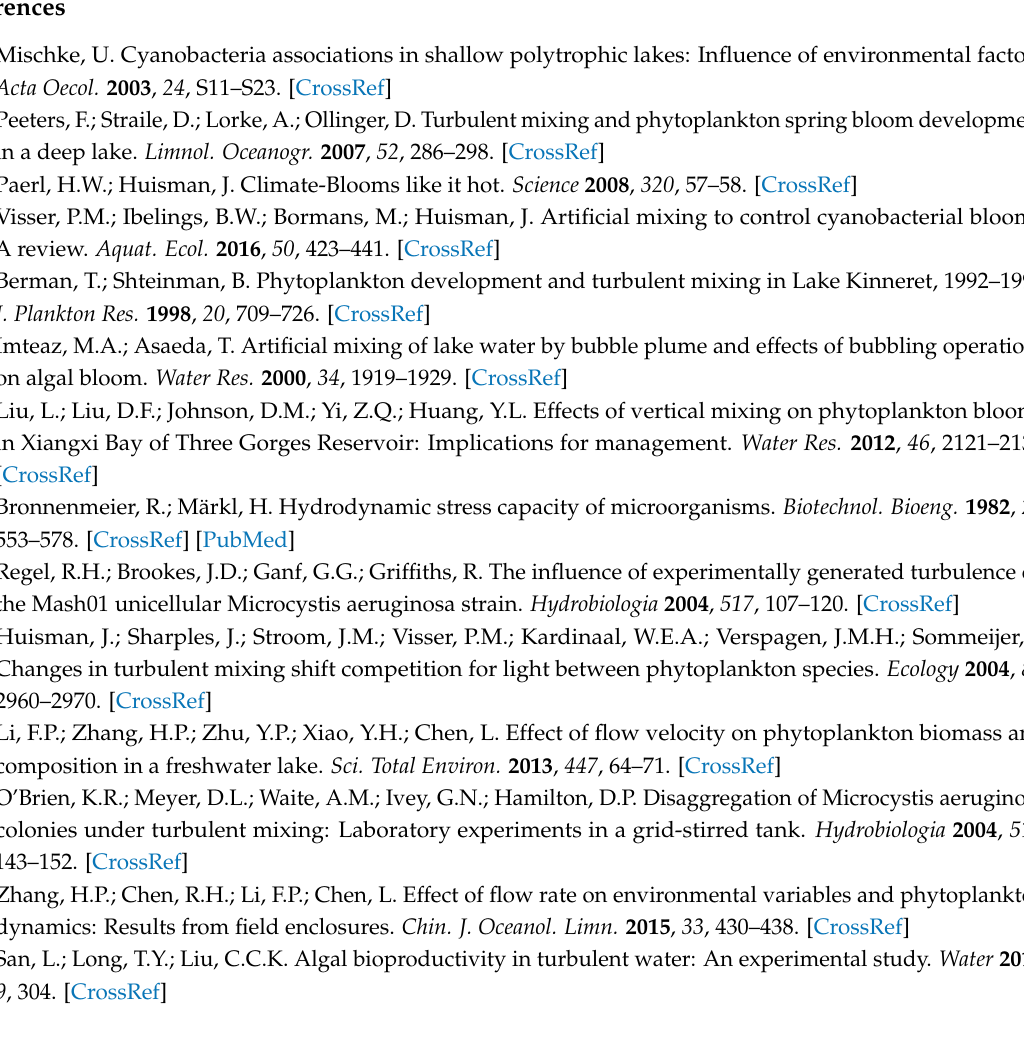
Table 1. The parameters estimation based on 95% confidence interval for maximum cell number of abundance. Table 2. The fitting evaluation parameters for maximum cell number of